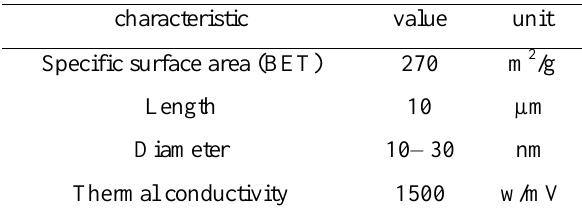
Table 1 . The characteristics of